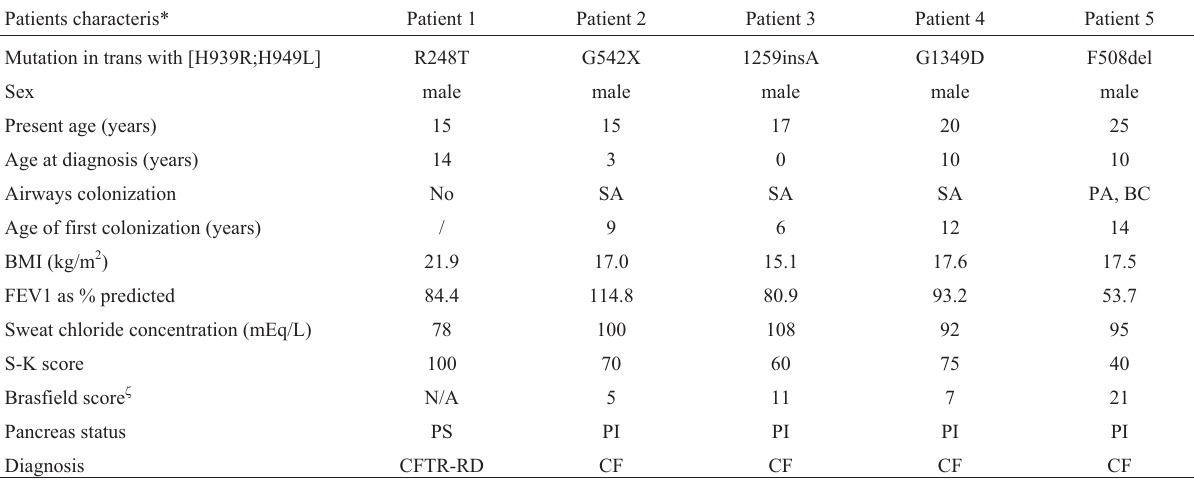
Table 1 - Clinical features of five unrelated patients with the complex allele [H939R;H949L]. Patients